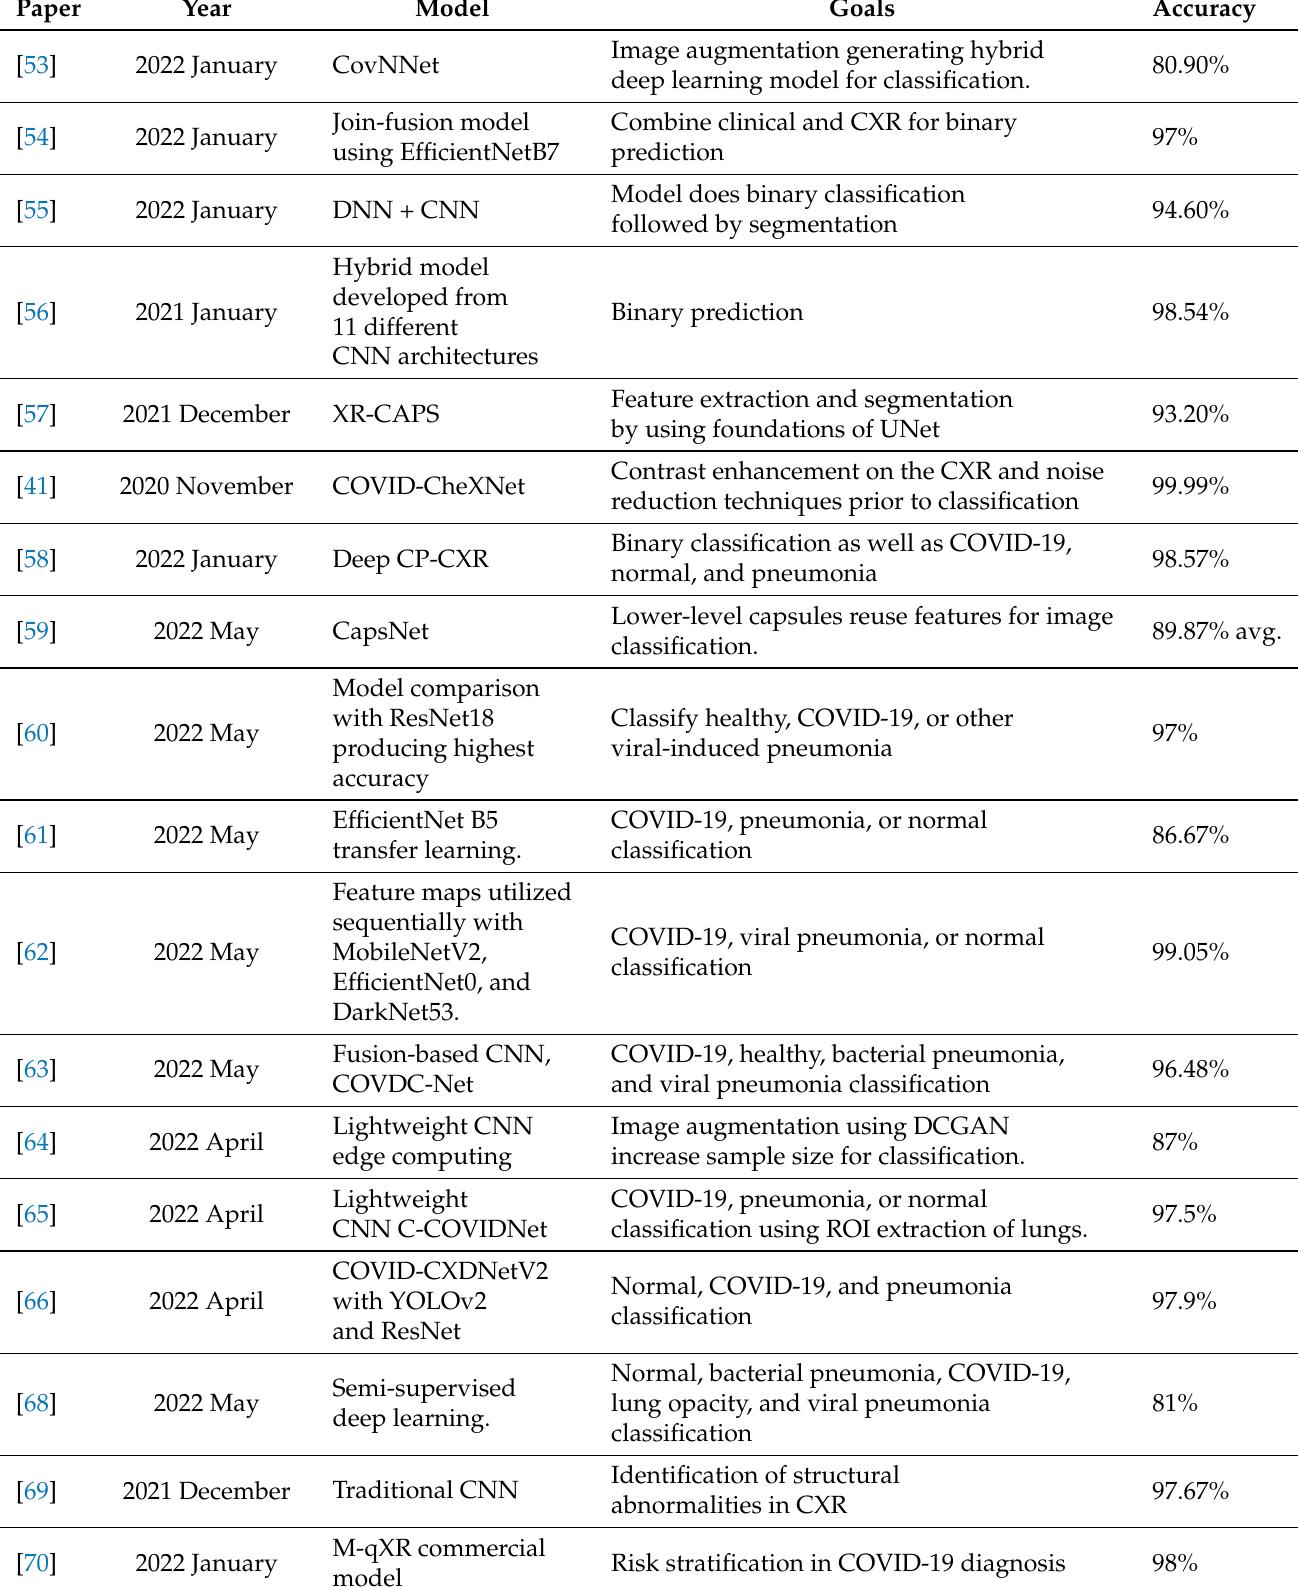
Table 2. Machine learning approach summarized using CXR